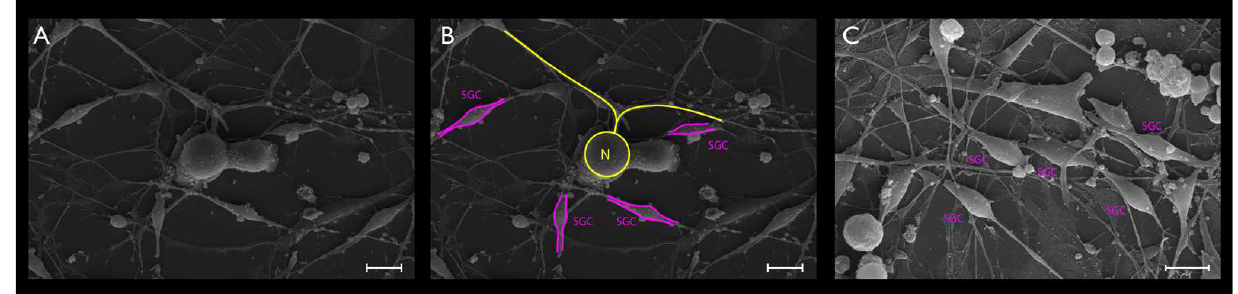
Figure 4. The TG cultured cells after a period of 24 h ( A – C ). Pseudounipolar neurons could be clearly visualized (yellow, B ). At this stage, SGCs clearly adopted a fusiform shape and were located at short distances from the TG neurons (pink, B ). Scale bars represent 10 µm.